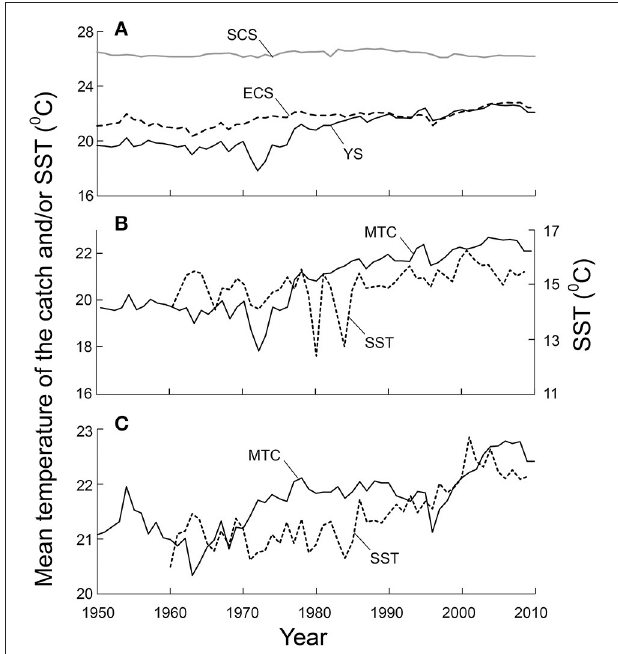
FIGURE 4 | Segmented regressions, as used to demonstrate that the increase of SST in the Yellow Sea began in 1968 (A) , and in 1962 in the East China Sea (B) .